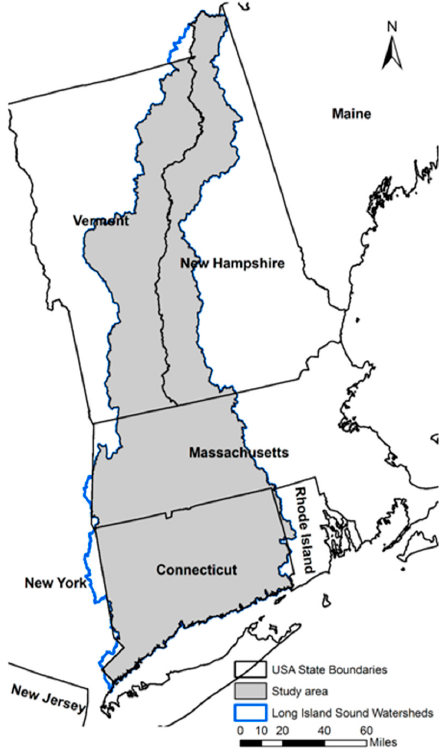
Figure 1. Location of the study area.